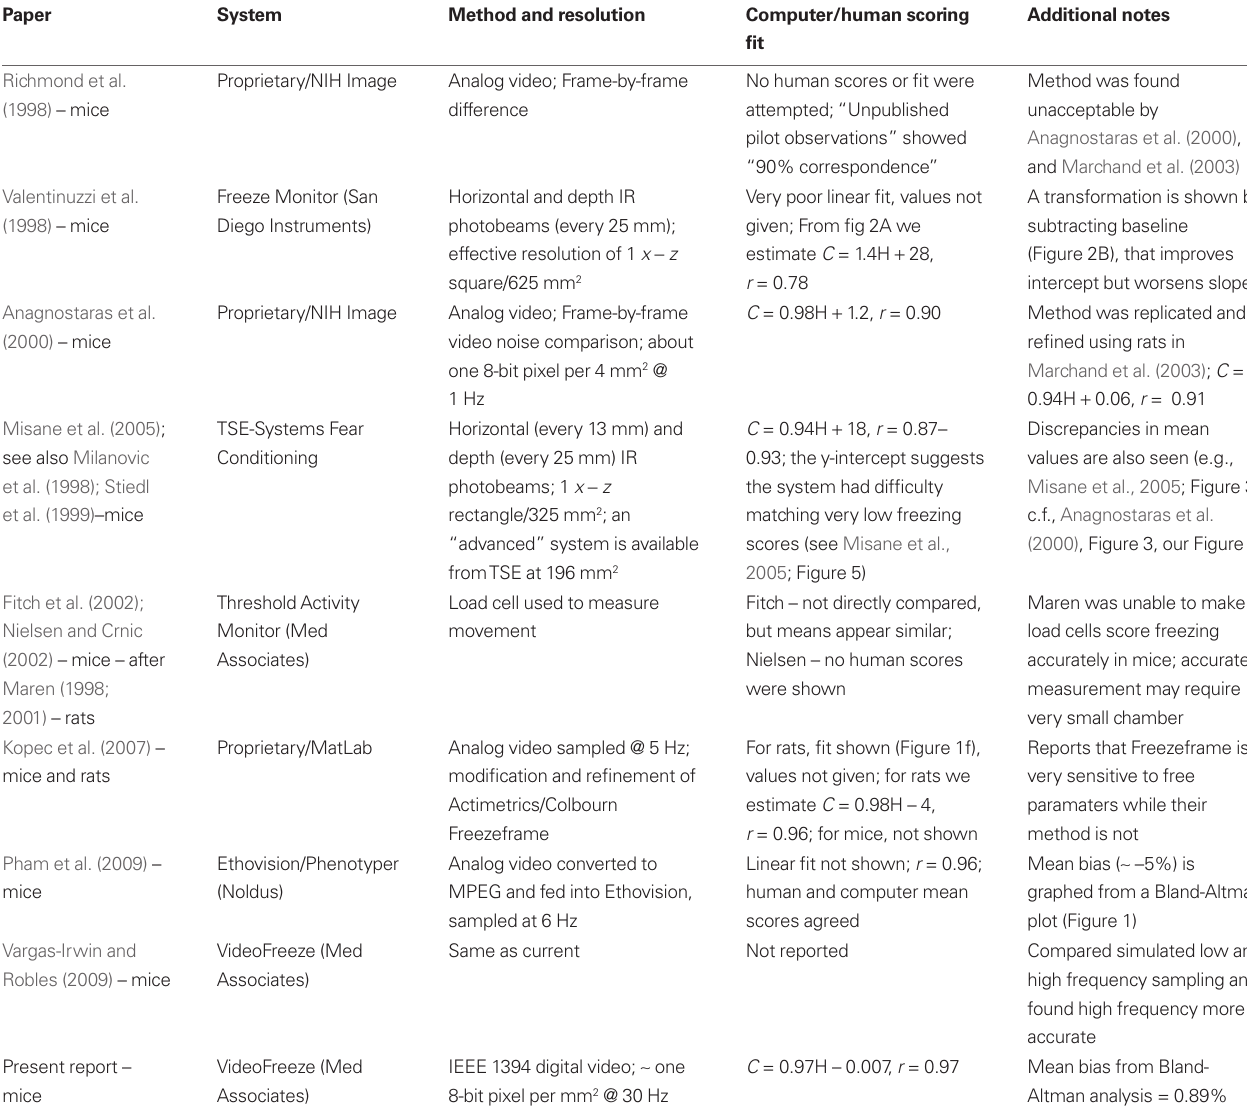
Table 1 | Published methods for scoring freezing behavior in